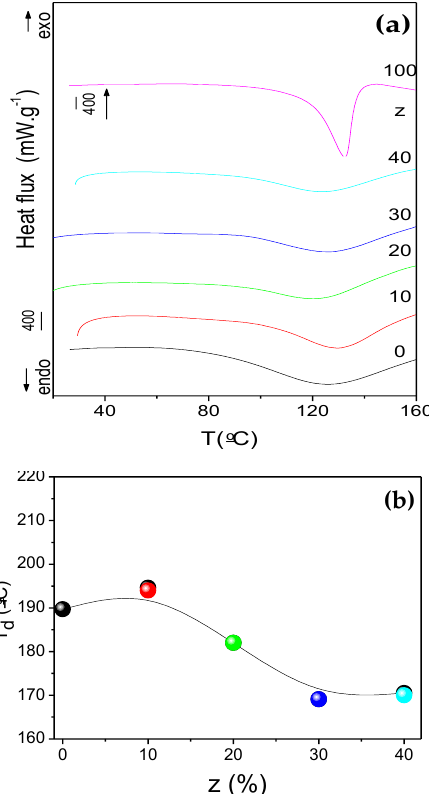
Figure 4. Differential Scanning Calorimetry (DSC) curves ( a ) and variation of the decomposition